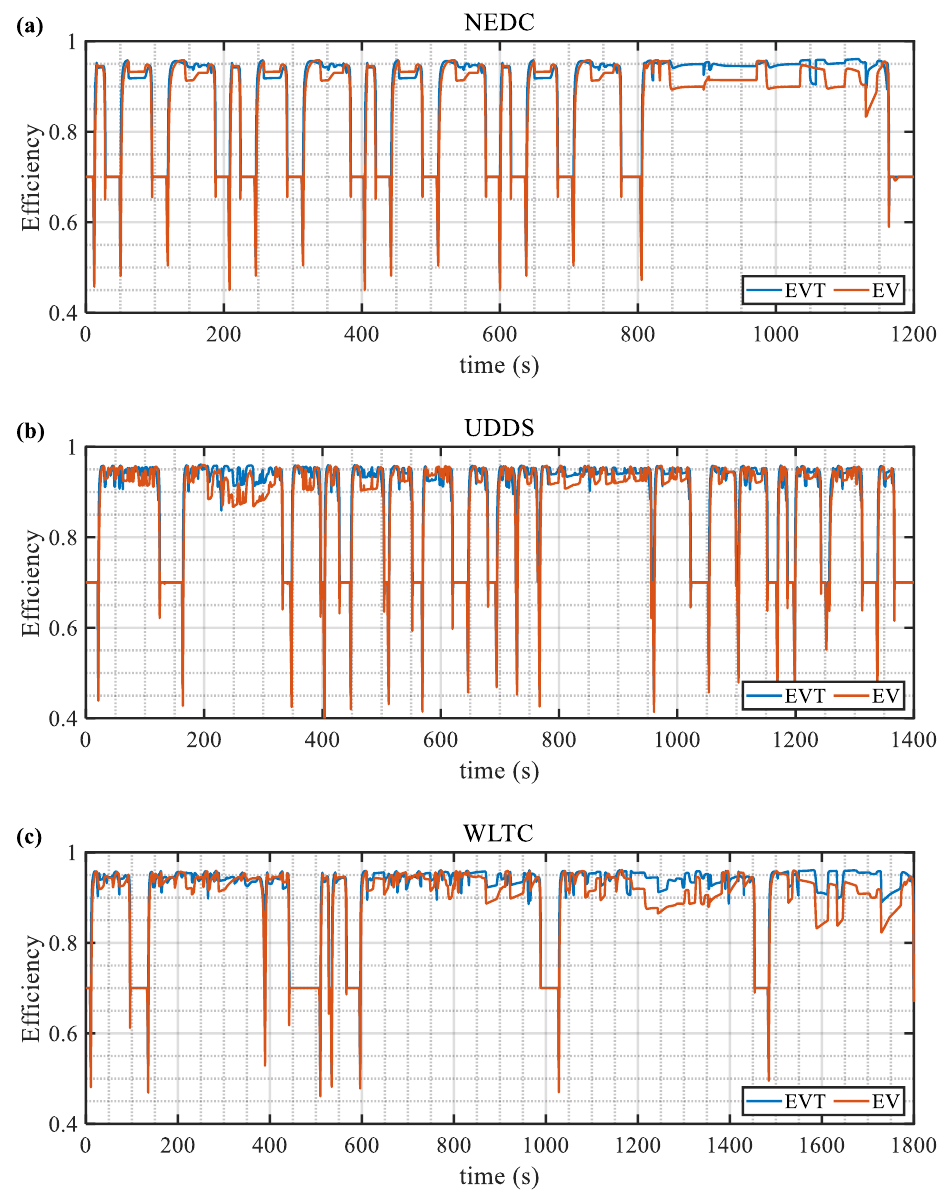
Figure 14. Motor efficiency in three driving cycles: ( a ) Efficiency under NEDC driving cycle; ( b ) Efficiency under UDDS driving cycle; ( c ) Efficiency under WLTC driving